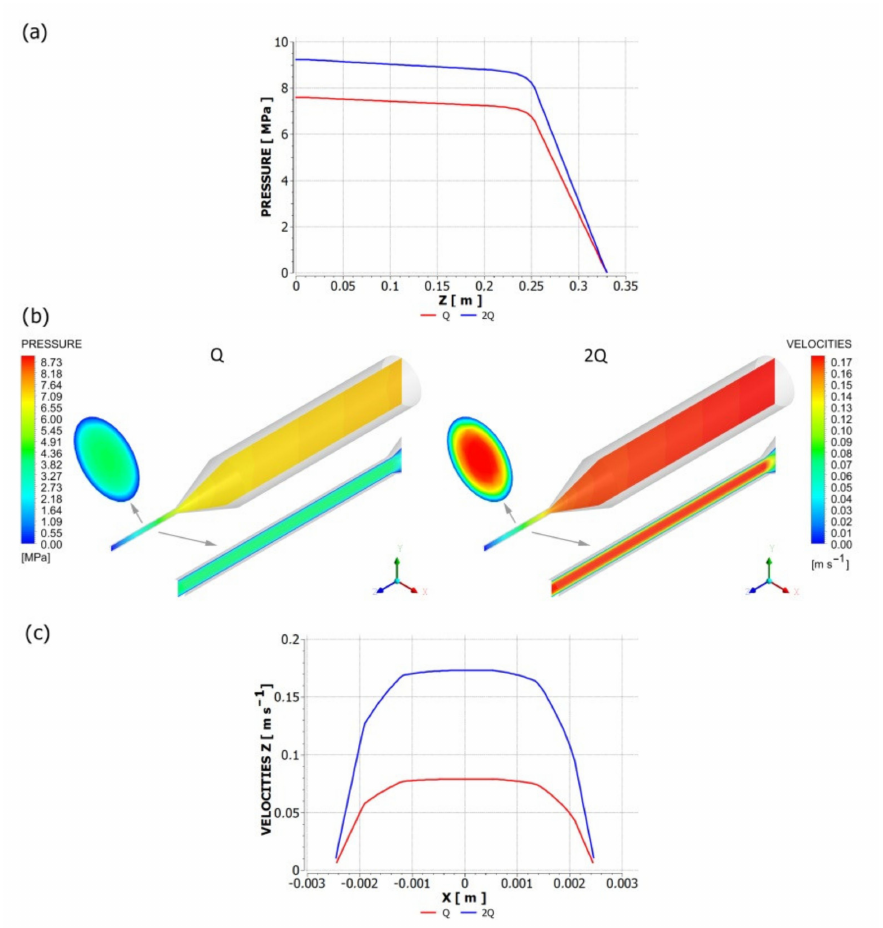
Figure 7. Pressure and velocity distributions for die flow ( F slip = 0.064, e slip = 0.43): Q = 0.001 kg/s. ( a ) pressure profile, ( b ) velocity distribution (in cross-sections indicated by arrows), and pressure distribution, ( c ) velocity profile.